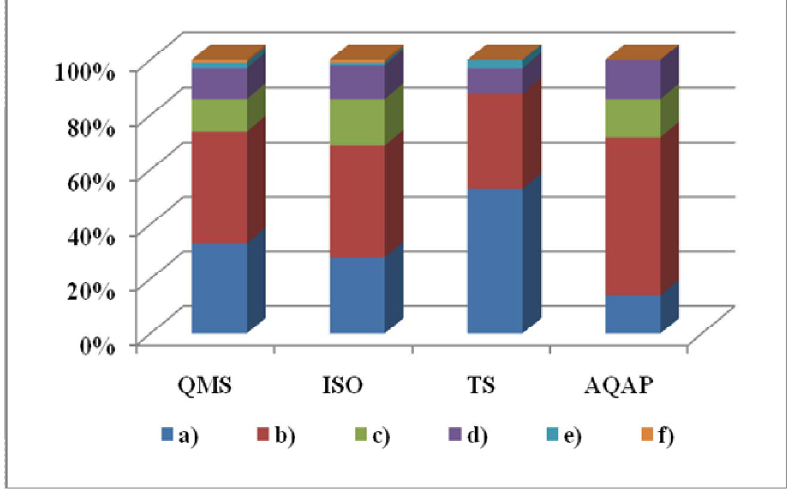
Figure 2 - Graphical representation of responses to question no.